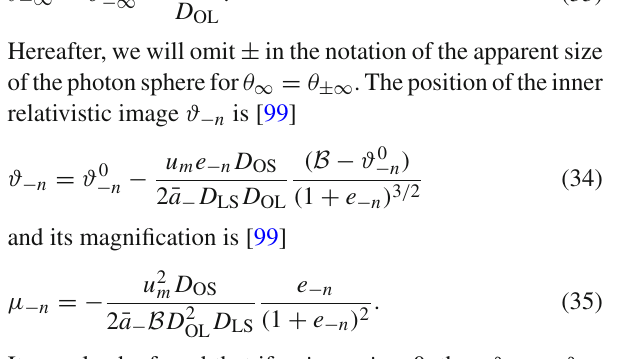
4 Observables for Sgr A* and M87* For current capability of gravitational wave detection and astronomical observation, it is still hardly to distinguish a horizonless ultracompact object from a black hole [38]. Therefore, We hypothesize that Sgr A* and M87* were two Lee-Wick ultracompact object s with the mass M SgrA ∗ = 4 . 28 × 10 6 M (cid:11) and the distance D OL , SgrA ∗ = 8 . 32 kpc [103] and with M M87 ∗ = 6 . 5 × 10 9 M (cid:11) and D OL , M87 ∗ = 16 . 9 Mpc [12]. Their angular observables, including the apparent radius of the photon sphere θ ∞ as well as the separations between the relativistic images s + 1 , ∞ , s ∞ , − 1 and s + 1 , − 1 , are shown in Fig. 3. On the domain D a , θ ∞ decreases with the incre- ment of κ . θ ∞ for Sgr A* ranges from 29.7 to 31.1 µ as for the Lee-Wick ultracompact object, bigger than its value of 26.4 μ as in the case of a Schwarzschild black hole; and θ ∞ becomes 22.3–23.2 µ as for M87* whereas its value for the Schwarzschild black hole is 19.7 µ as. The angular separa- sphere s + 1 , ∞ quickly reaches its peak values of 75 nanoarc- second (nas) for Sgr A* and of 56 nas for M87* at κ ≈ 1 . 780